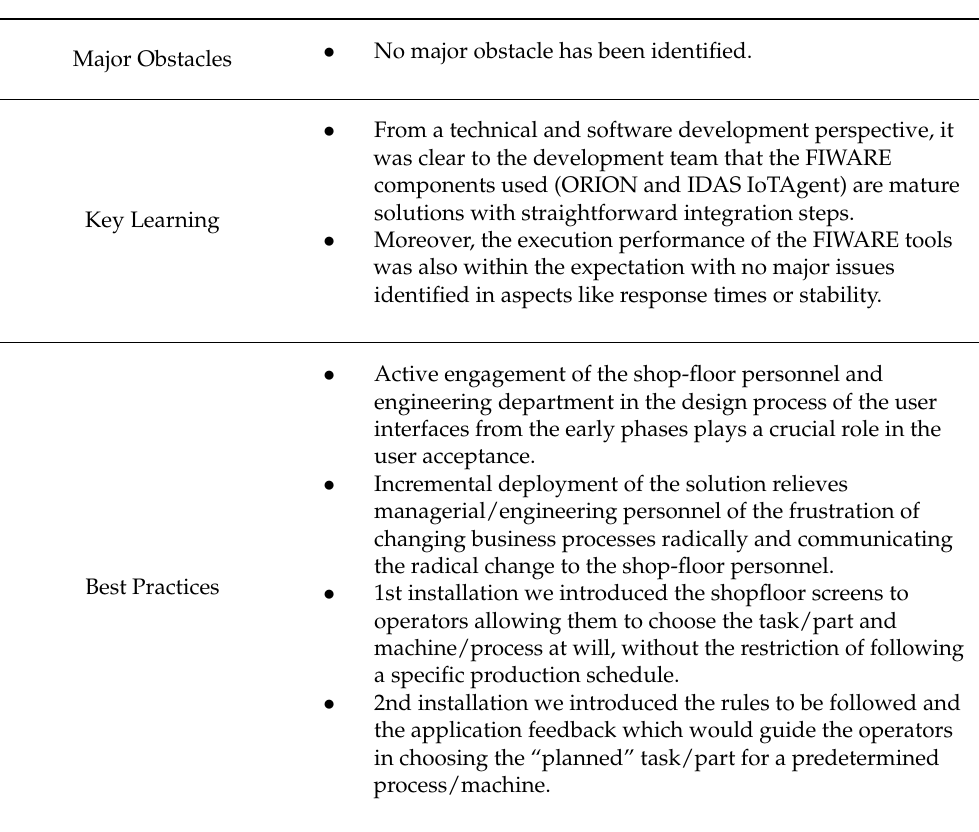
Table 4. Experiment with qualitative analysis from a technical point of